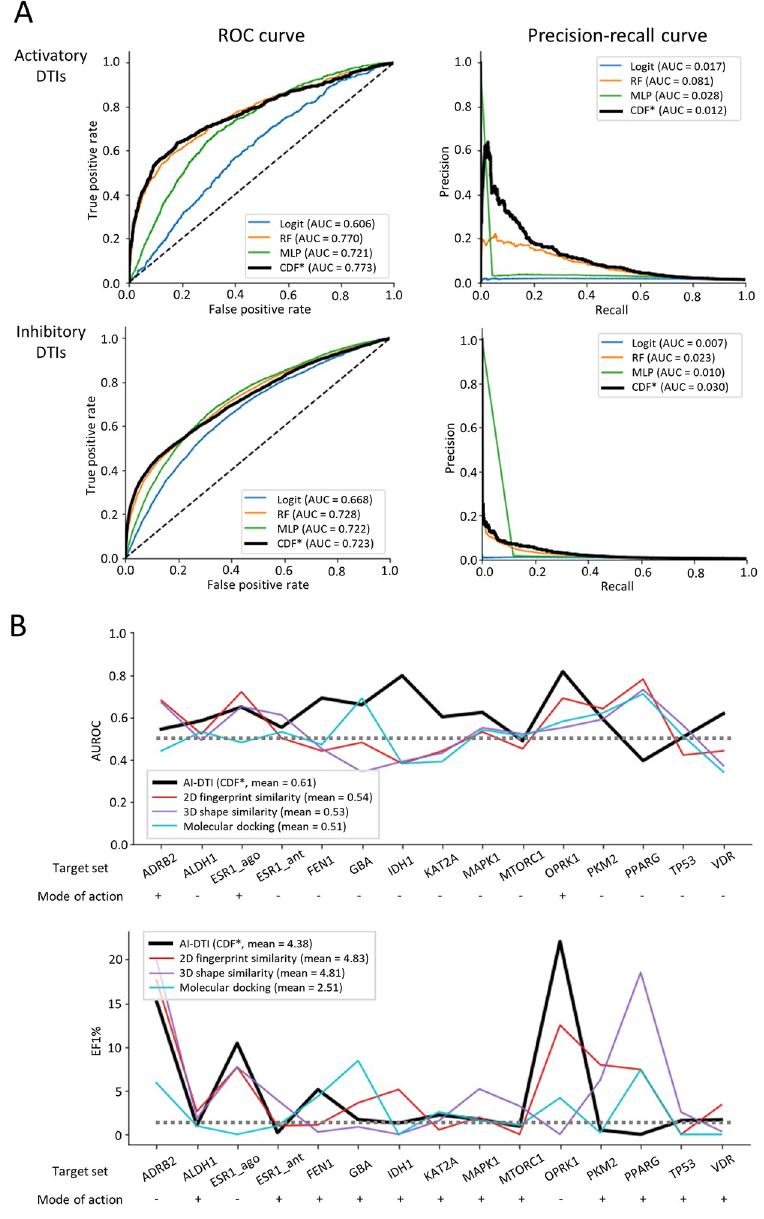
Fig 4. Assessment of performance on independent datasets. (A) Performance curves for activatory (top) and inhibitory (bottom) DTIs on the DrugBank dataset. * CDF model with 8 estimators in each cascade layer and 500 trees in each forest. Logit, logistic regression; RF, random forest; MLP, multilayer perceptron. CDF, cascade deep forest. (B) Performance comparison between our optimized model and the conventional virtual screening methods on LIT-PCBA. * CDF model with 8 estimators in each cascade layer and 500 trees in each forest. score exceeds the default threshold of our model (0.5). To assess how uncommon the predicted score is, we constructed a reference distribution and compared a relative rank of the score (i.e., top %) to the reference distribution of interaction scores. The reference distribution was defined as the distribution of interaction scores calculated using our method for DTI pairs between 2500 FDA-approved drugs and a target of interest.